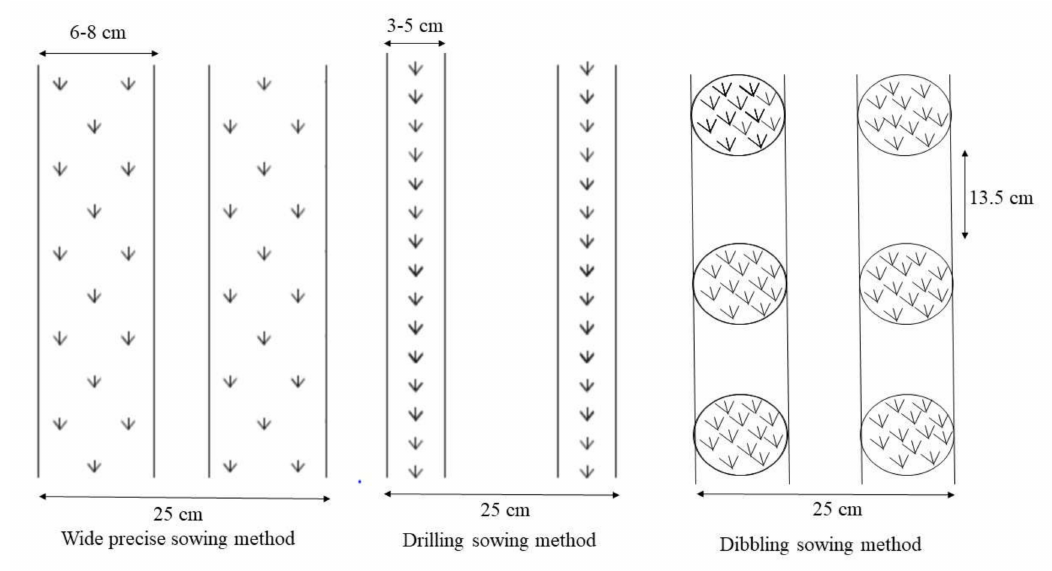
Figure 2. Schematic diagram of the wide precise sowing, drilling, and dibbling sowing